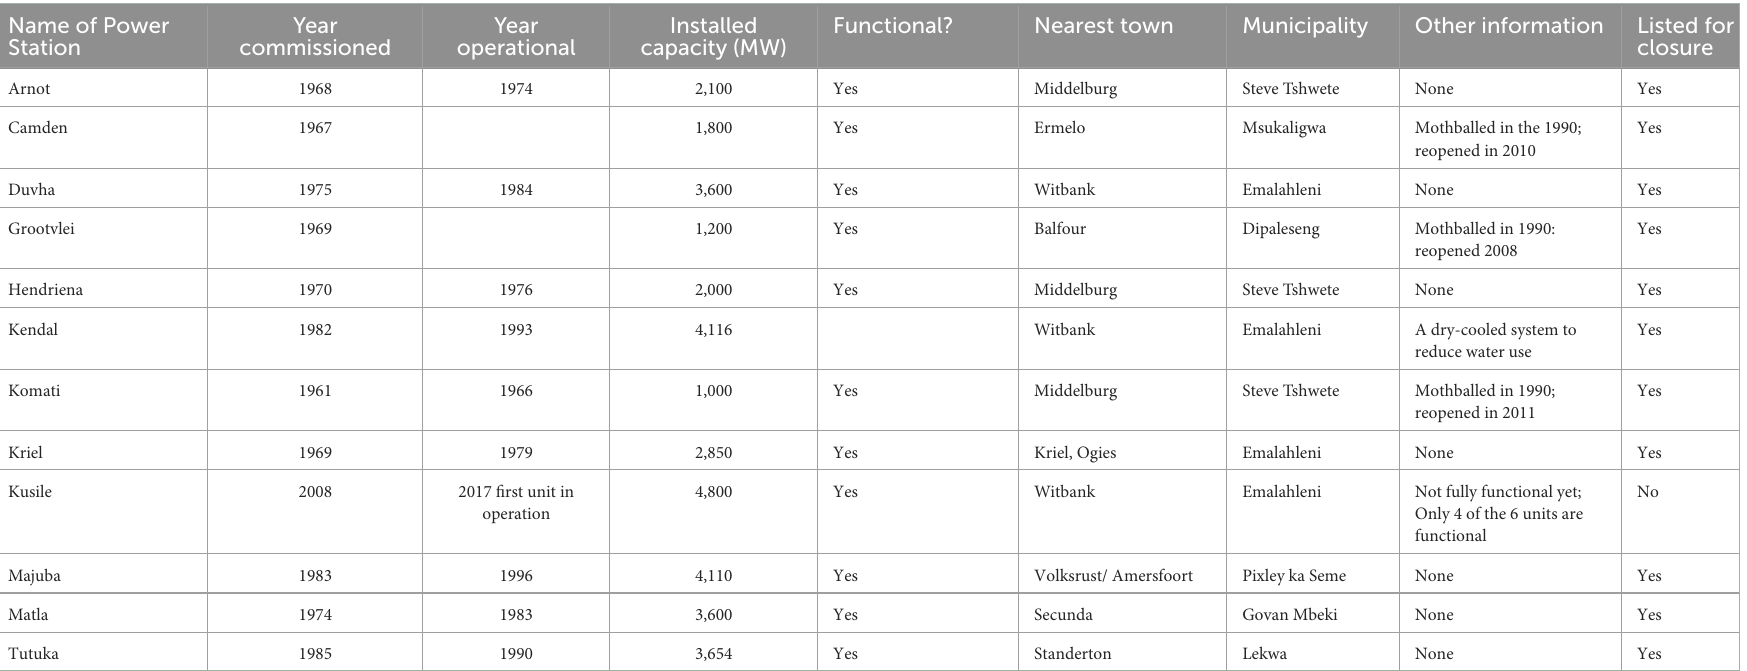
TABLE 1 Eskom power stations in Mpumalanga,